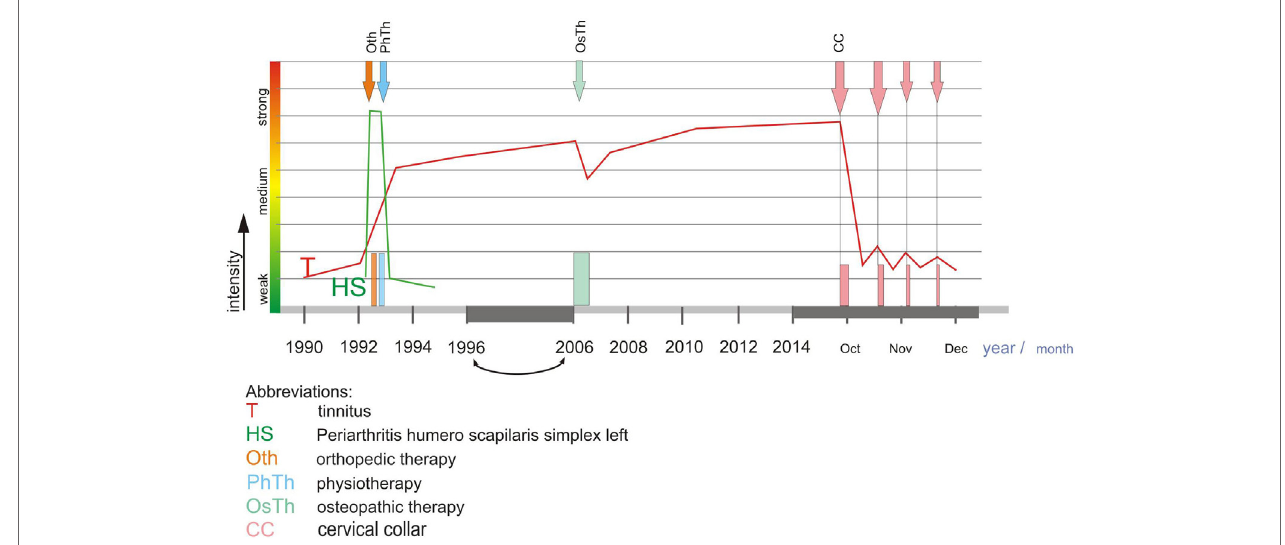
FIGURe 1 | the figure represents the full length of disease history of this single case, from the beginning 20 years ago with a cervical pain syndrome associated with tinnitus . When the cervical pain syndrome was intensely treated with established treatments (mainly physiotherapy of various types; for details, see the respective signs within figure) the CPS only gradually improved over time, even worsened after a chiropractic measure. After successful treatment of the cervical pain syndrome, the tinnitus, nevertheless, was chronic, persistent over about 20 years. The tentative recommendation to consider this type of tinnitus as a minor symptom of an incompletely treated cervical syndrome was based on own personal experiences and observations (Karl Bechter, see Introduction), and led to recommend exclusively the intermittent CC use in an outpatient setting (with no other treatment). CC was used repeatedly during day time, initially more frequent, after 2 weeks less frequent, and after 4 weeks the usage nearly ended because of rapid, complete relief from tinnitus. Abbreviations: T, tinnitus; HS, periarthritis humero scapilaris simplex left; Oth, orthopedic therapy; Pth, physiotherapy; OsTh, osteopathic therapy; CC, cervical